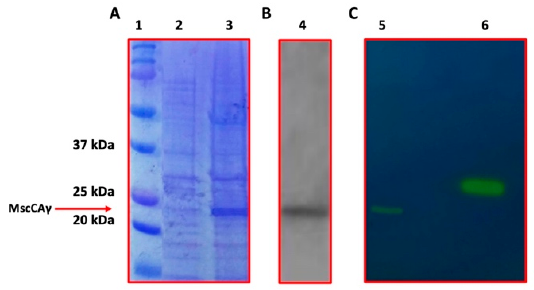
Figure 4. SDS-PAGE electropherogram ( A ), Western-Blot ( B ), and Protonogram ( C ). Legend: Lane 1, molecular markers, molecular mass values starting from the top: 150, 100, 75, 50, 37, 25, 20, and 15 kDa; Lane 2: cellular extract before induction with IPTG; Lane 3, MscCA γ overexpression induced by IPTG addition; Lane 4, MscCA γ band after affinity chromatography purification and detected by His-tag antibody; Lane 5, MscCA γ hydratase activity, which is denoted by the yellow band due to the CO 2 hydration reaction catalyzed by the enzyme on the polyacrylamide gel and responsible of the pH variation from 8.2 to the transition point of the dye; Lane 6, commercial bovine CA, used as positive controls.